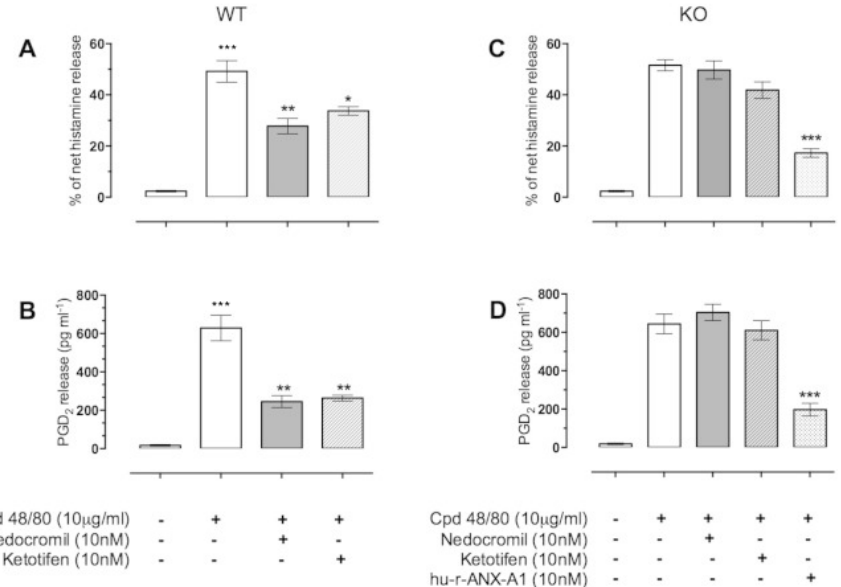
Figure 1. The inhibitory action of the mast cell ‘stabilisers’ nedocromil and ketotifen is dependent upon the presence of the mast cell AnxA1. BMDMCs from both AnxA1 +/+ (WT) (panels A , B ) and AnxA1 − / − (KO) (panels C , D ) mice were cultured and prepared as described. Cells were stimulated with compound (Cpd) 48/80 (10 µ g/mL) prior to treatment with either nedocromil (10 nM) or ketotifen (10 nM) and, in the case of the AnxA1 − / − cells, 10 nM hu-r-AnxA1. Data are expressed as mean ± SEM of n = 3 experiment (*** p < 0.001, ** p < 0.01, * p < 0.05) (figure reproduced with permission from the rights holder, Elsevier) [104].